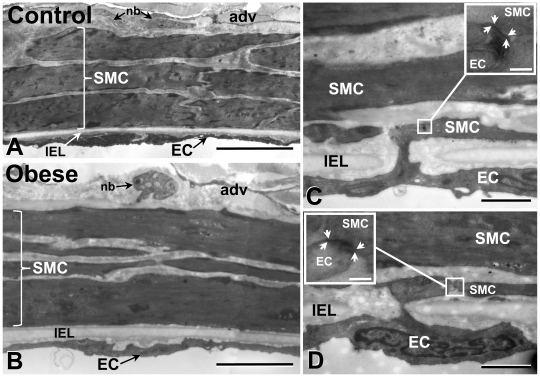
Morphology of control and obese rat mesenteric artery.The media of obese rat mesenteric arteries contain more smooth muscle cell (SMC) layers than control (A, B;

Table 2
). Myoendothelial gap junctions were present on endothelial cell (EC) projections in both control and obese arteries (C, D and insets). Such sites have characteristic pentalaminar gap junction morphology (inset, between arrows). adv, adventitia; IEL, internal elastic lamina; nb, nerve bundle. Bars; A, B, 10 µm; C, D, 1 µm; inset, 100 nm.